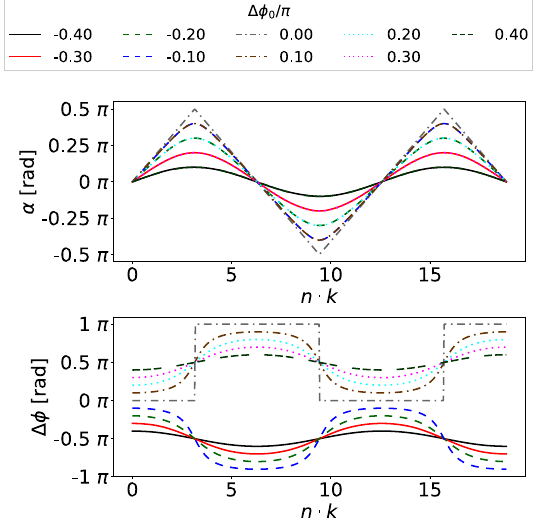
.FIG. 3. Analytical solutions [Eq. (4)] for the on-resonance case q ¼ 0 and α ¼ 0 as a function of nk for different values of Δ ϕ 0